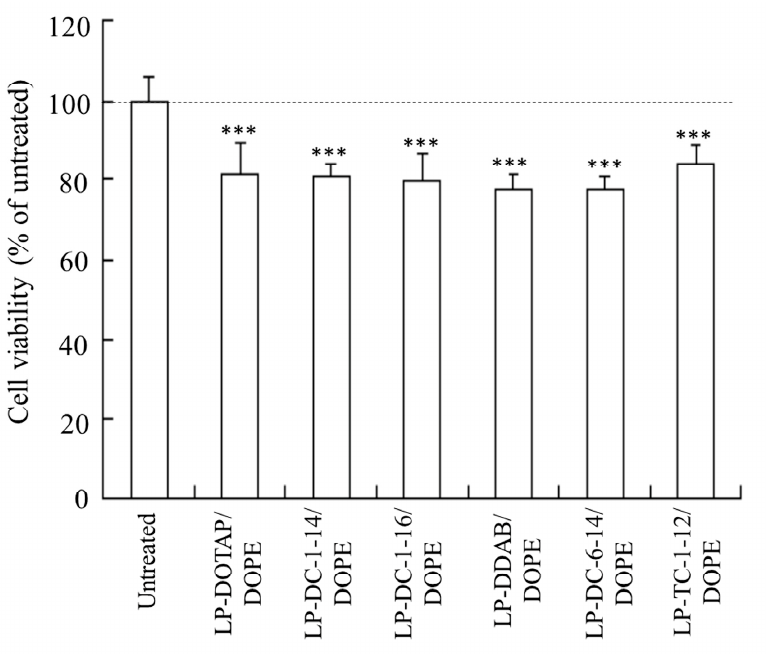
Figure 6. E ff ect of cationic lipids in mRNA lipoplexes on cell viability 24 h after transfection of FLuc mRNA lipoplexes into HeLa cells. FLuc mRNA lipoplexes were added to HeLa cells at 0.5 µg/mL mRNA. Each column represents the mean + S.D. ( n = 6). *** p < 0.001, compared to untreated cells. To examine the e ff ect of the transfection activity of the mRNA lipoplexes in other cell lines, we transfected LP-DC-1-14/DOPE, LP-DC-1-16/DOPE, and LP-TC-1-12/DOPE lipo- plexes into A549 and PC-3 cells. Among them, LP-DC-1-16/DOPE and LP-TC-1-12/DOPE